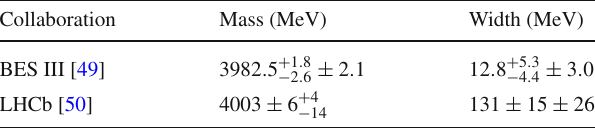
Table 1 The resonance parameters of the newly reported Z cs states from different collaborations [49,50]